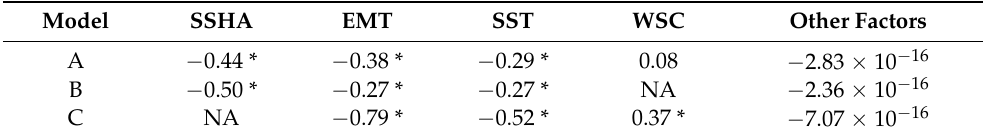
Table 1. Multiple regression analysis of region-averaged chlorophyll-a concentration (CHL) with respect to sea surface height anomaly (SSHA), wind stress curl (WSC), sea surface temperature (SST) and Ekman mass transport (EMT) averaged during the period